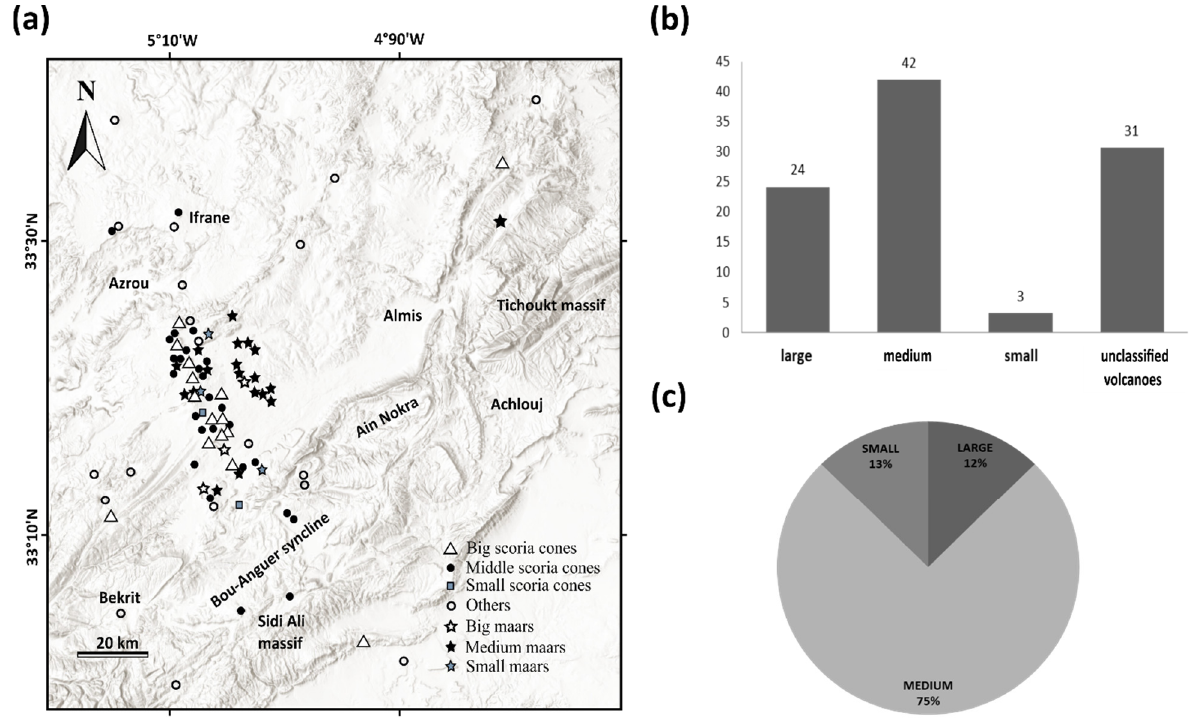
Figure 9. ( a ) Map showing the size distribution of scoria cones of MAVF; ( b ) the distribution of MAVF scoria cones as a function of volume (km 3 ) according to the approach of Dóniz-Páez et al. [83] ; ( c ) the distribution of MAVF maars as a function of crater diameter (m) according to the approach of Gevrek and Kazanci [93] .